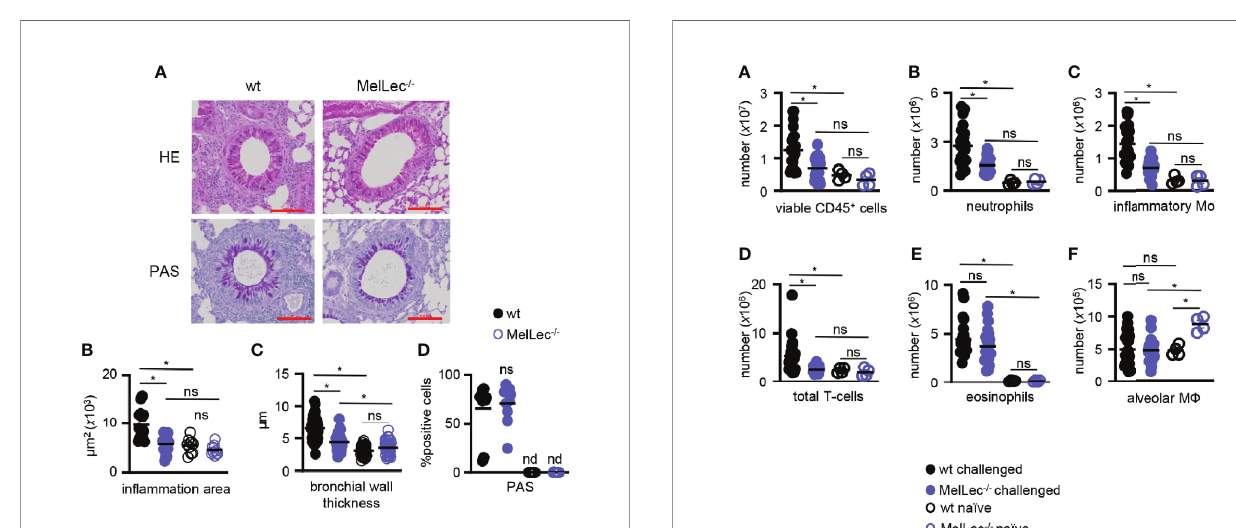
FIGURE 3 | Loss of MelLec leads to reduced pulmonary cellular in fl ammation. (A) Total CD45 + leukocytes, (B) neutrophils (Ly6G + CD11b + ), (C) in fl ammatory macrophage/monocytes (Ly6c + CD11b + ), (D) total T-cells (CD11b - CD11c - MHCII - ), (E) eosinophils (SIGLEC-F + CD11b + ) and (F) alveolar macrophages (SIGLEC-F + CD11c + ) in the lungs of wild type (wt) and MelLec -/- mice, as indicated, on day 23 following allergic sensitization and challenge with live Aspergillus fumigatus conidia. Cellular counts from naïve mice are also shown (n=4). See Supplementary Figure 1 for gating strategy). Shown are pooled data (with mean) from at least two independent experiments (n>20 mice). *p<0.05. n.s., not signi fi cant. Statistical signi fi cance was determined using ANOVA.